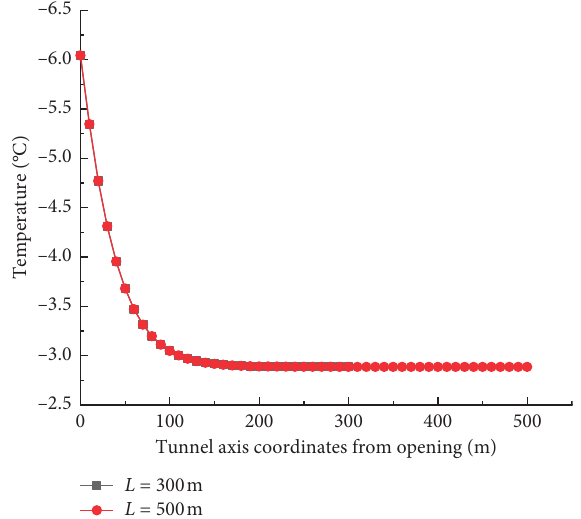
Figure 14: Longitudinal average temperature distribution characteristic curve of the